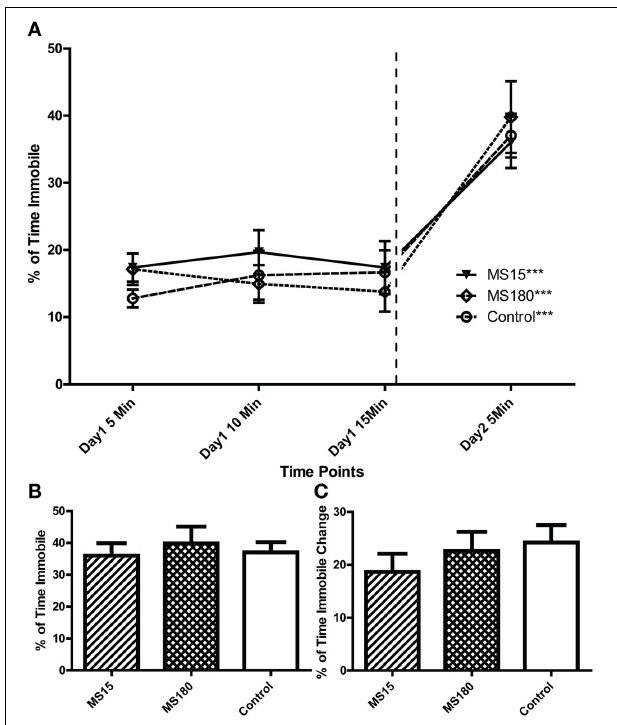
FIGURE 6 | Early-life experience does not alter WKY depression-like behavior in the forced swim test. Adult male WKY control rats as well as WKYs that were separated from their dams for 15min (MS15) or 180min (MS180) per day during the first 2 weeks of life were examined in the 2-day forced swim test. All groups showed similar immobility levels across Day 1 (A) and Day 2 (A,B) , and all groups displayed significantly more immobility during the second test session vs. the first (B,C) ∗∗∗ p < 0 . 001 for time effect, Day 2 vs. Day